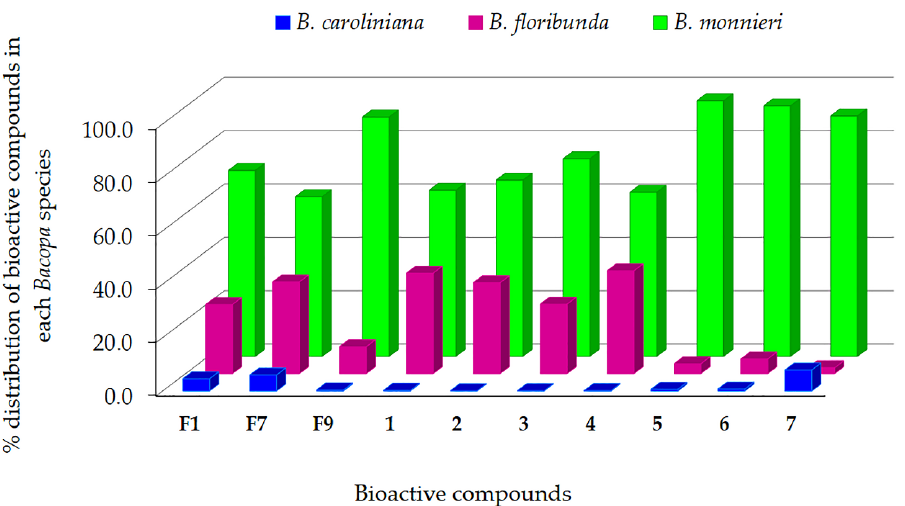
Figure 6 . Percentage distribution of ten bioactive compounds in each Bacopa species, calculated by division of the average MS signal intensity of the compound in each species by a sum of signal intensities of the compound in three Bacopa species ×100 .